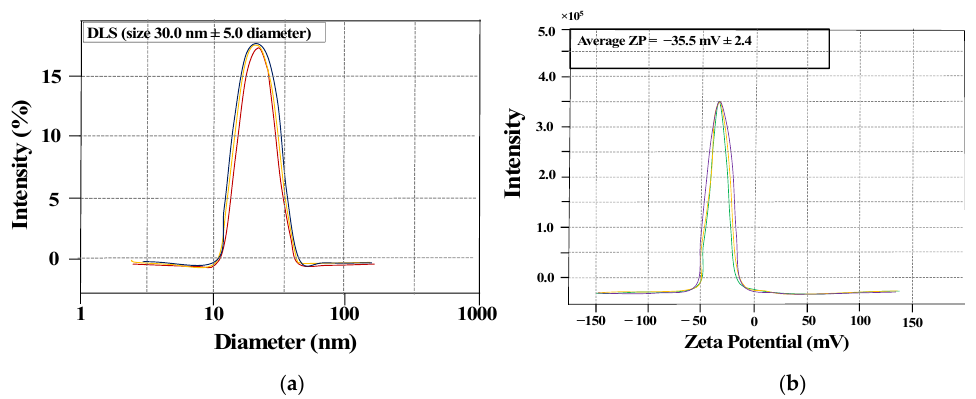
Figure 4. DLS analysis of AgNPs@AA having a diameter of 30 nm ( a ) Zeta potential of AgNPs@AA ( b ).